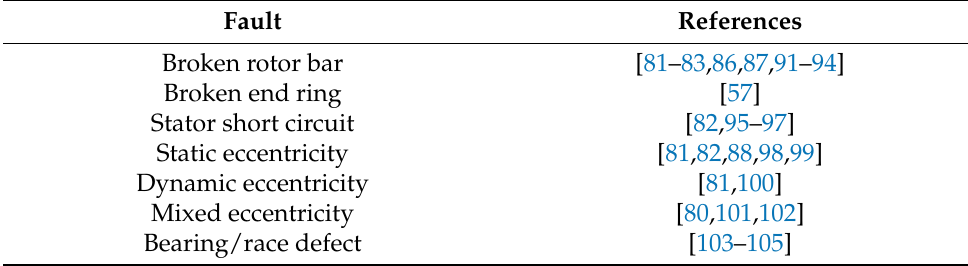
Table 4. FEM references for different types of